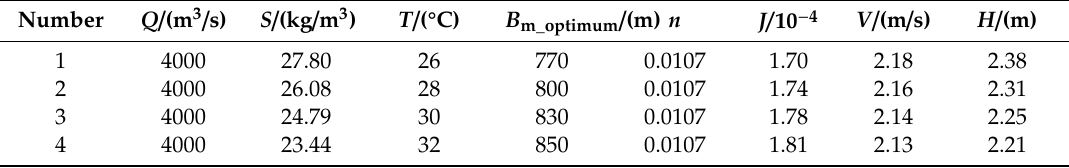
Figure 5. The B m ~ J and B m ~ n curves of the LYR: ( a ) B m ~ J curves of the LYR; ( b ) B m ~ n curves of the LYR (the circles represent critical points). Table 6. The flow and sediment conditions of critical points.